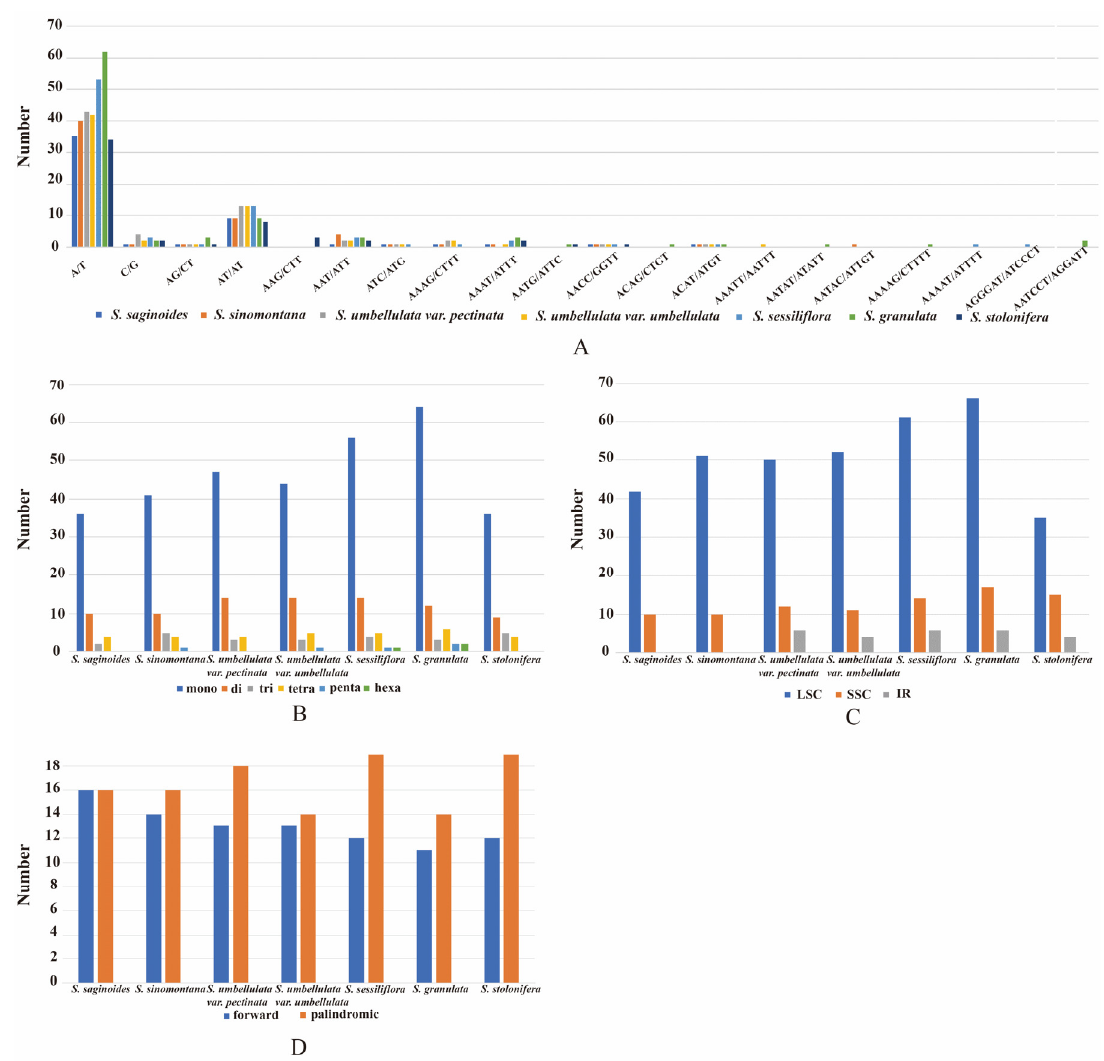
Figure 6. Repeats analysis among cp genomes of Saxifraga . ( A ) Distribution of all repeat units for SSRs in each species. ( B ) The number of different types for SSRs in each species. ( C ) Distribution of SSRs, respectively, in LSC, SSC, and IR regions. ( D ) The number of different types for long